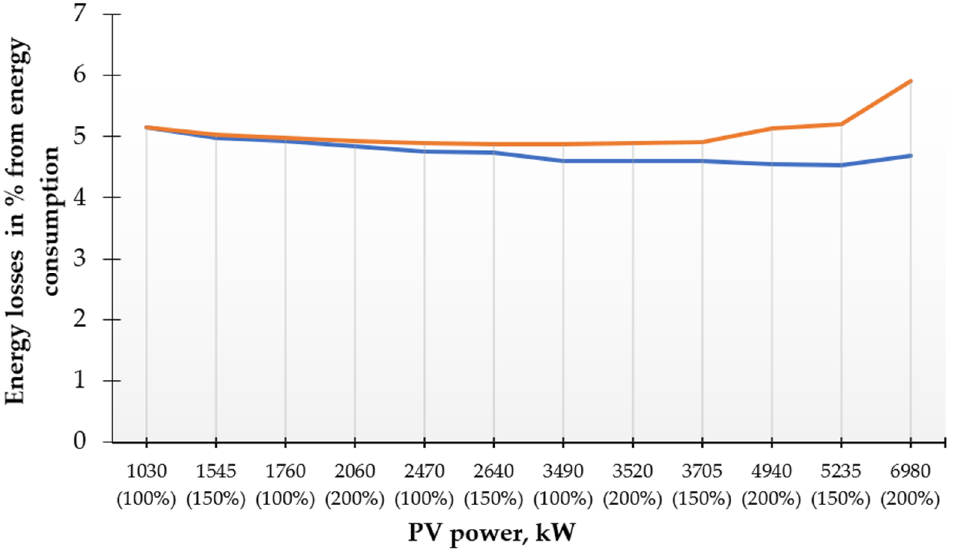
Figure 8. Energy losses (%) depending on the PV installed power: blue line—DPs, orange line—EComPs.